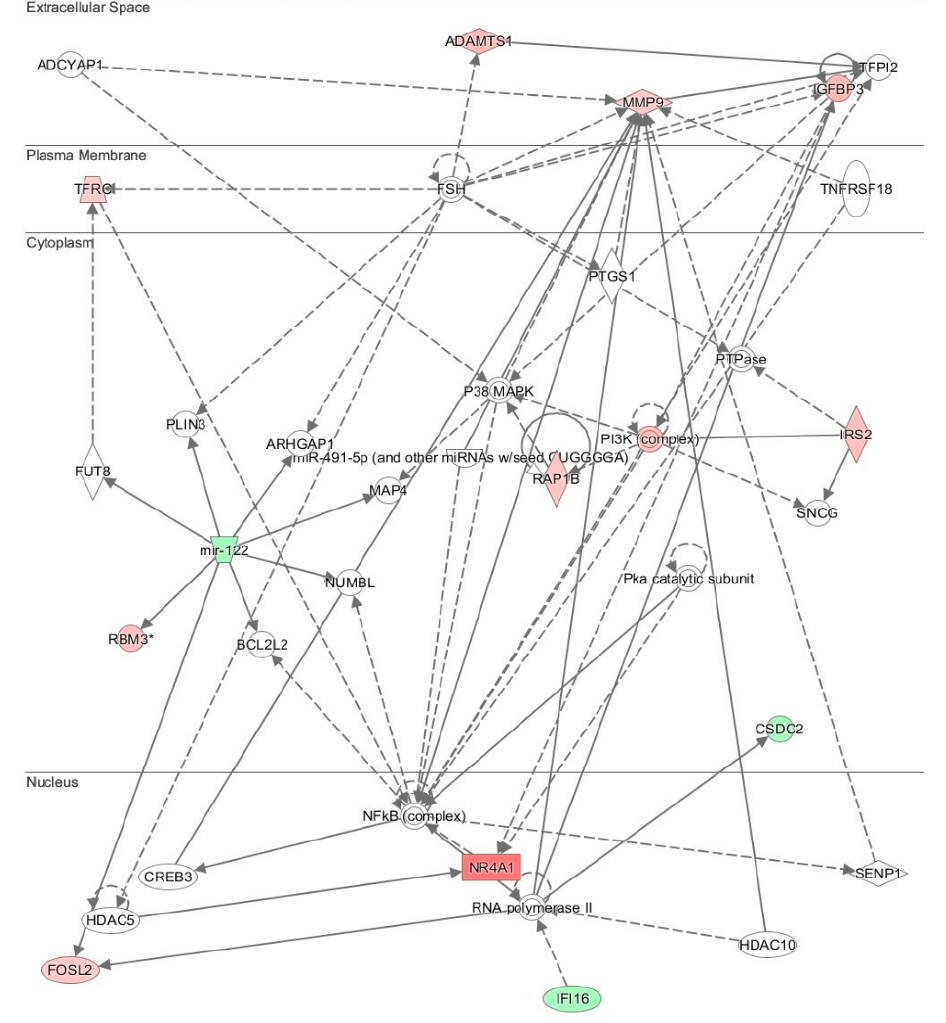
Figure 3. Ingenuity Systems Pathway (IPA) analyses. Network of genes affected by deh-T3 β treatment. Upregulated genes are shown in red shaded shapes, and downregulated genes are shown in labeled green shaded shapes. Non-colored areas represent genes added by IPA when searching for biological relationships using NR4A1 as the searching